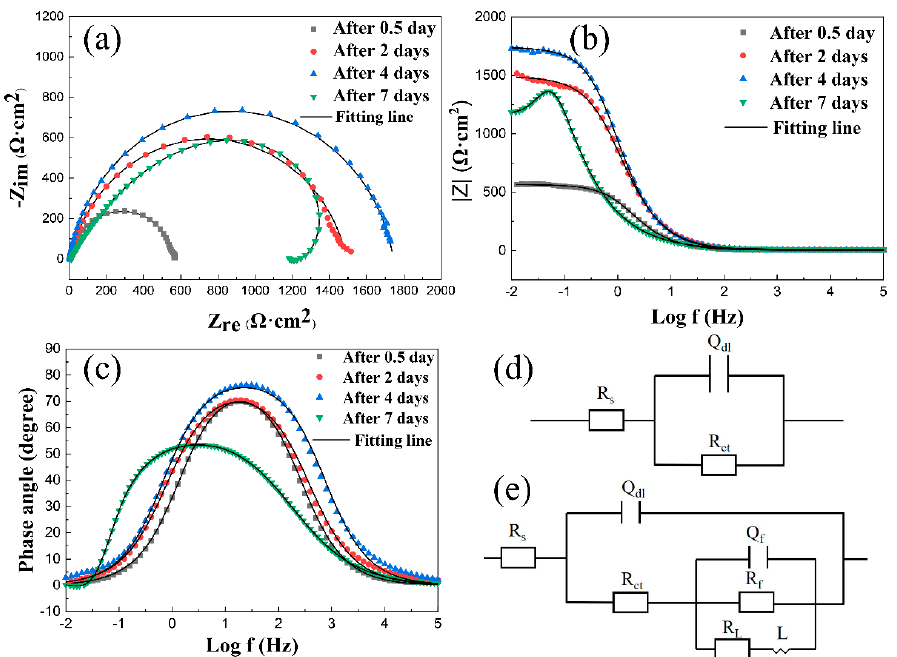
Figure 15. EIS plots of L245N standard steel after different times: ( a ) Nyquist diagram; ( b ) Bode impedance vs. frequency diagram; ( c ) Bode phase angle vs. frequency diagram, and electrochemical equivalent circuits for EIS fitting after different times: ( d ) 0.5–4 days; and ( e ) 7 days. Table 7. Electrochemical impedance parameters fitted from EIS data.